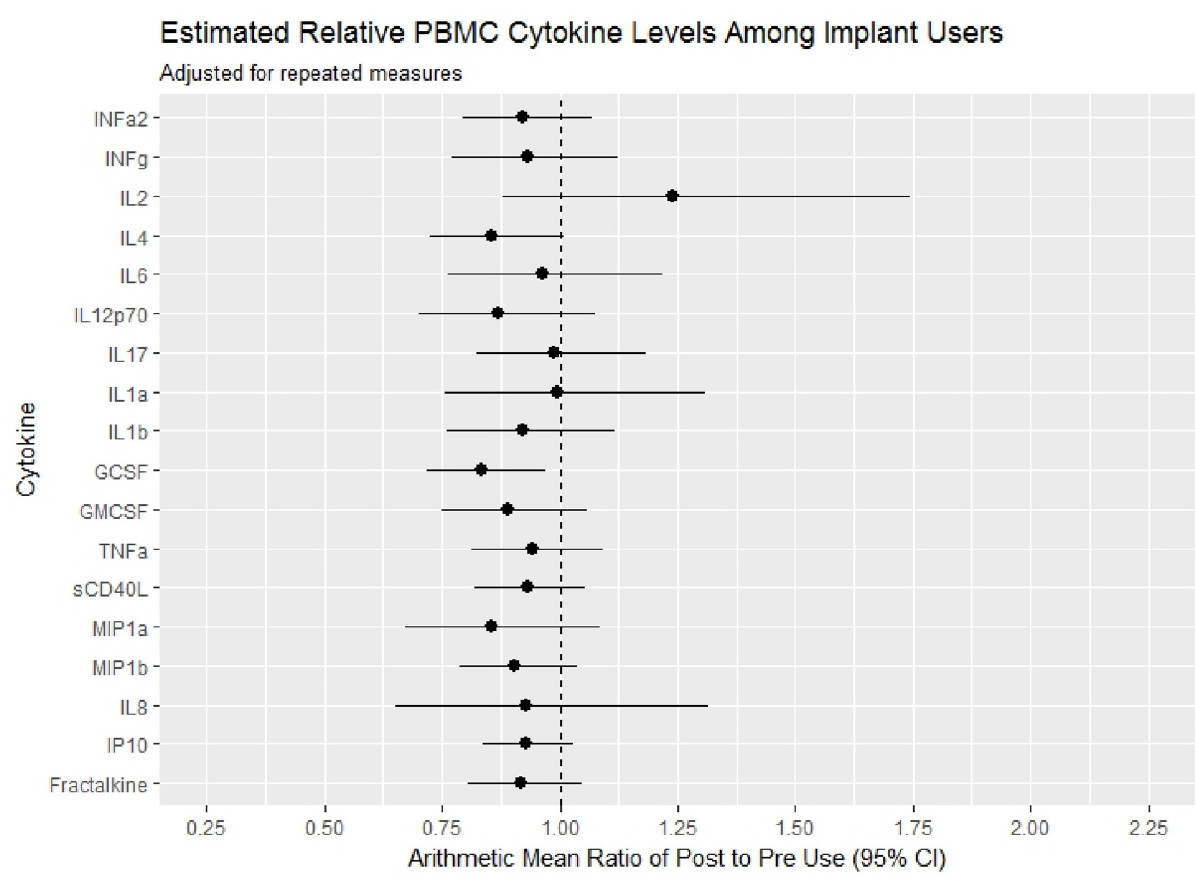
Fig 4. Forest plot of arithmetic mean ratio of cytokine levels post-implant compared to pre-implant use with 95% confidence intervals, adjusting for repeated measures.